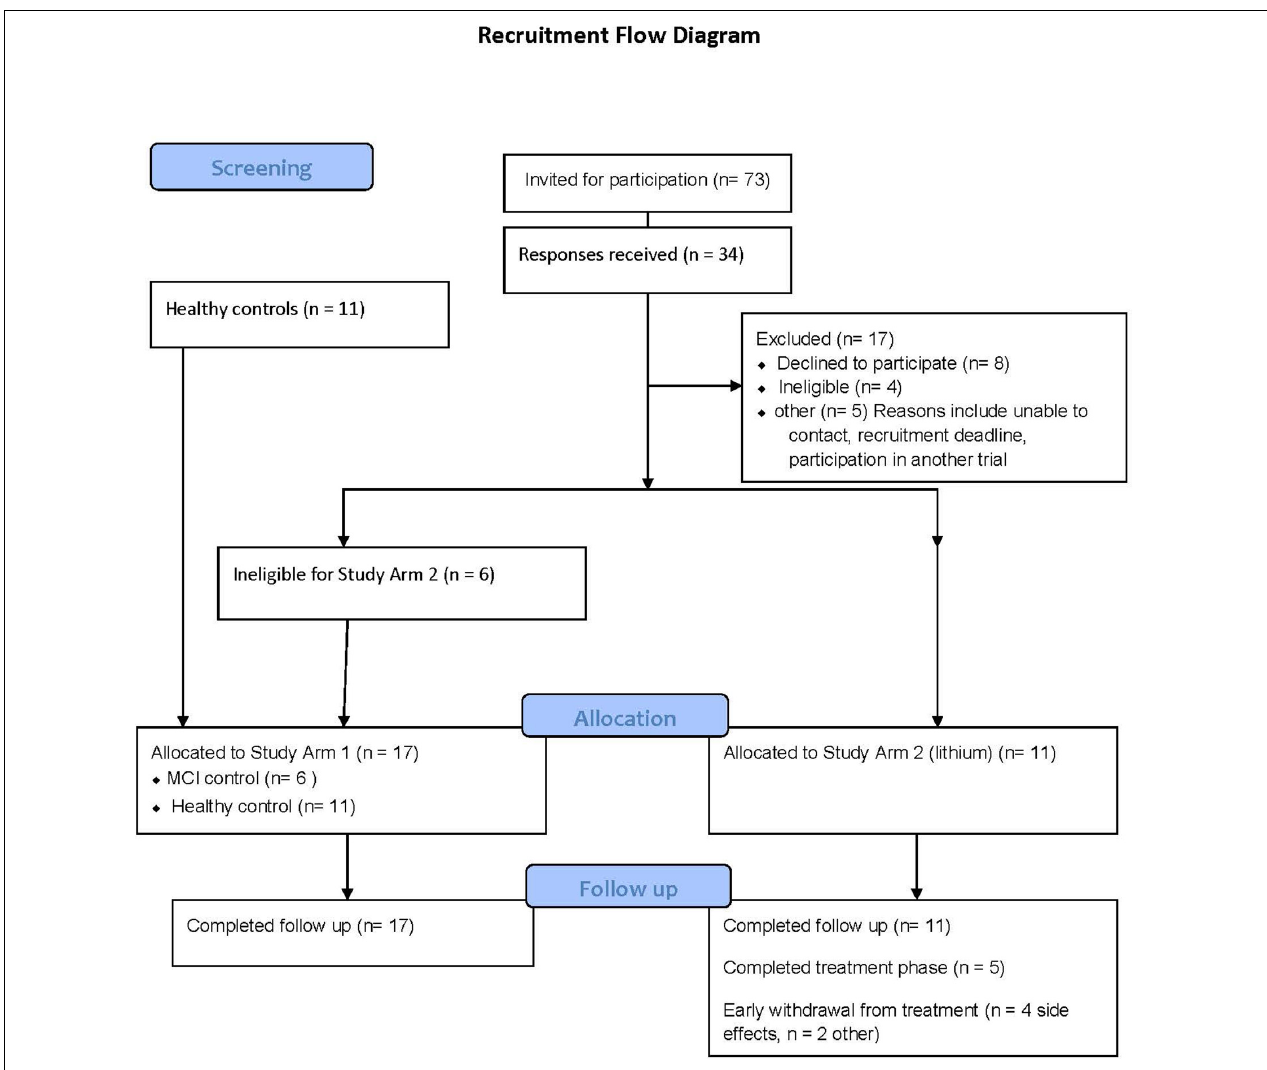
FIGURE 2 | Consort diagram detailing the recruitment process for the clinical studies.